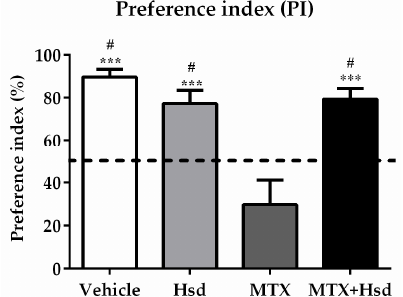
Figure 2. Significant differences were detected among the four groups in terms of preference index (PI) in the novel object location test. The PIs of the vehicle, Hsd, and MTX + Hsd groups were significantly different from 50% chance (# p < 0.05), but that of the MTX group was lower than 50%. The dashed line indicates 50% chance. The PI measured in the MTX group differed significantly from the vehicle, Hsd, and MTX + Hsd groups (*** p < 0.001).